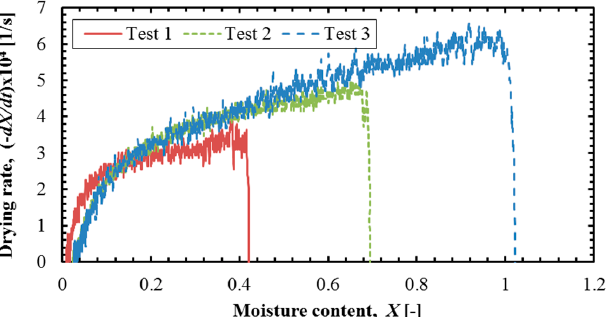
Figure 6. Drying rate curve plot of 10 mm sample at the test temperature of 150 °C.